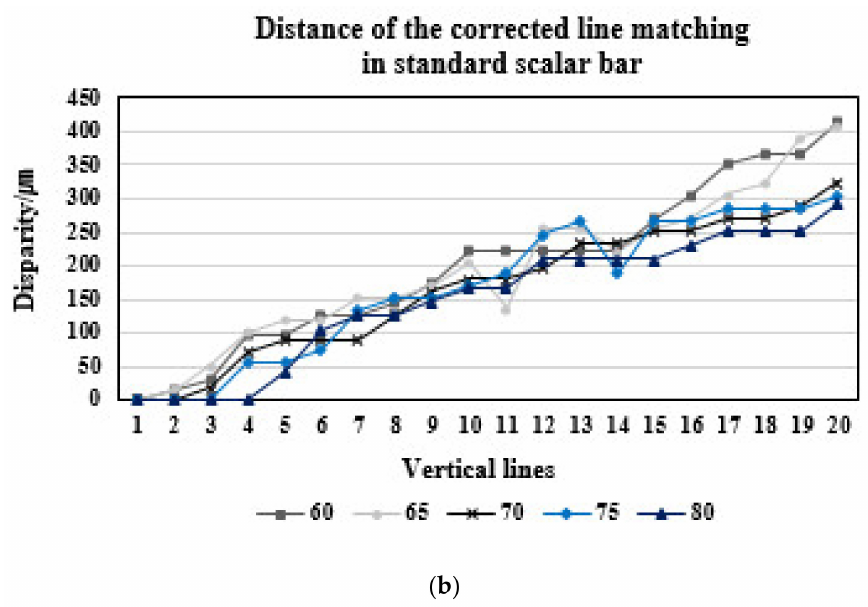
Figure 9. The matching result of the stereo image for a vertical line pattern, including the depth information. ( a ) The matching result of the distorted stereo image, ( b ) the matching result of the corrected stereo